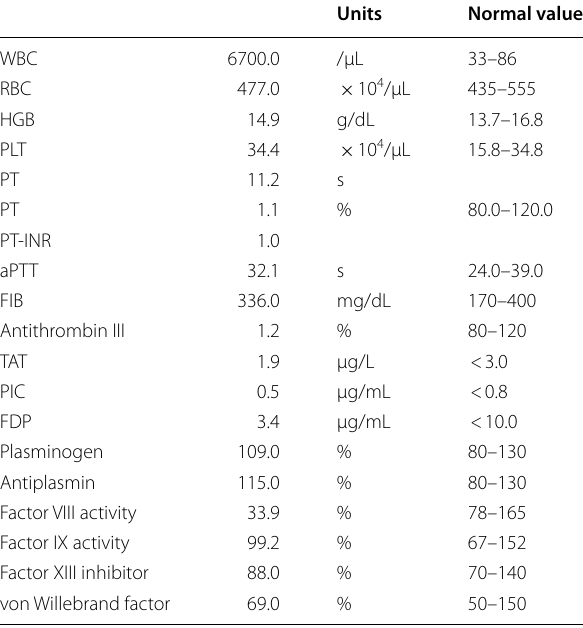
Table 1 The main blood test of coagulation